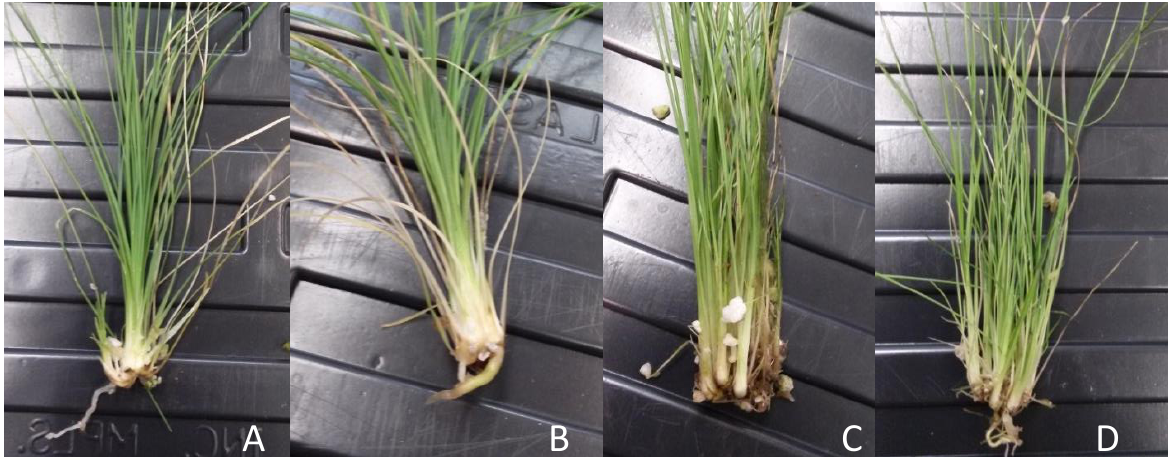
Plants 2021 , 10 , x FOR PEER REVIEW